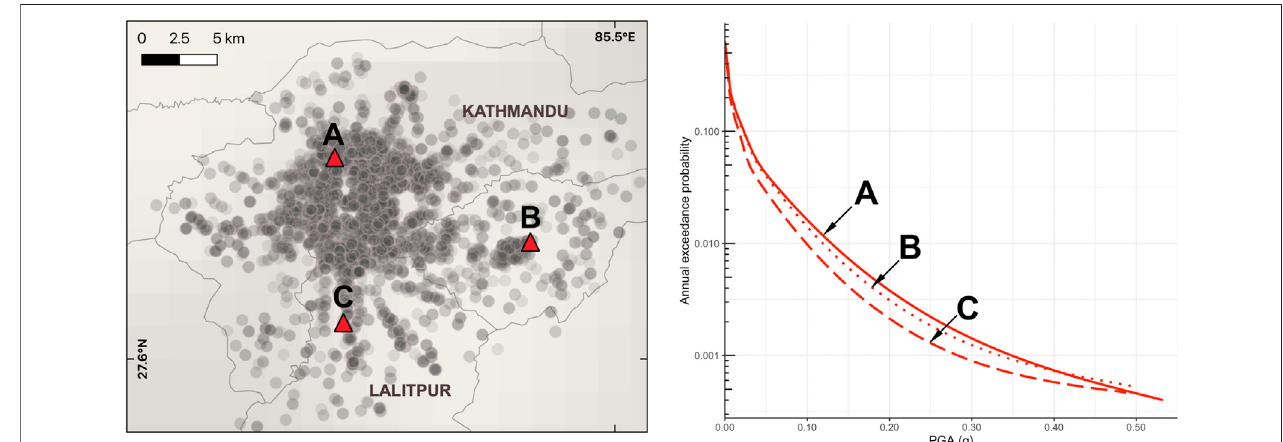
FIGURE 6 | Hazard curves for three sample school building locations in the analysis.